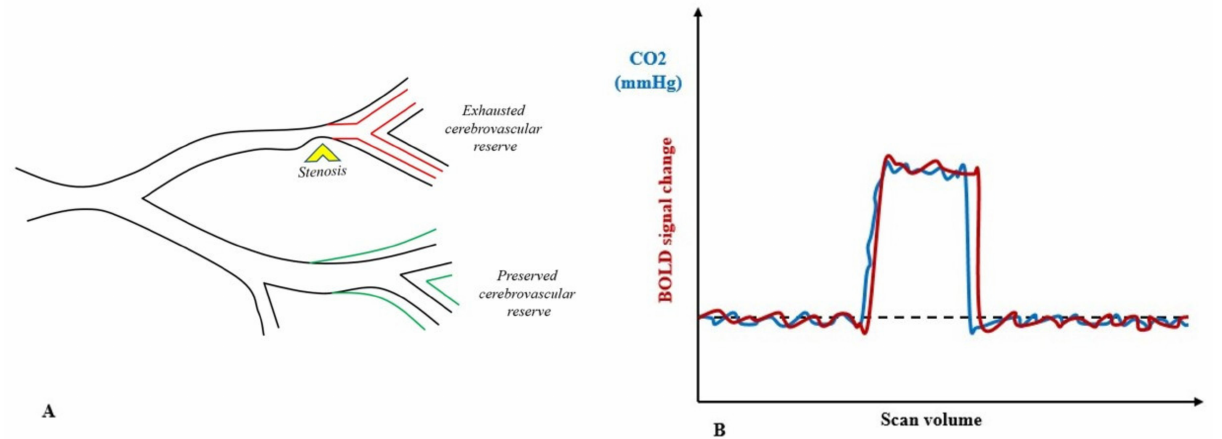
Figure 3. Cerebrosvascular reactivity. Panel ( A ) shows a schematic of encroached vasodilatory reserve and downstream of stenosis. Upon vasodilatory stimulus, all vessels will be stimulated to dilate, but flow increase in those with preserved vasodilatory reserve will reduce the flow distal to regional resistance. (Adapted by Sobczyk, O.; Battisti-Charbonney, A.; Fierstra, J.; Mandell, D.M.; Poublanc, J.; Crawley, A.P.; Mikulis, D.J.; Duffin, J.; Fisher, J.A. A conceptual model for CO2-induced redistribution of cerebral blood flow with experimental confirmation using BOLD MRI. NeuroImage 2014 , 92 , 56–68. ISSN 1053-8119. https://doi.org/10.1016/j.neuroimage.2014.01.051). Panel ( B ) shows a controlled standardized hypercapnic stimulus and its correlation to BOLD signal